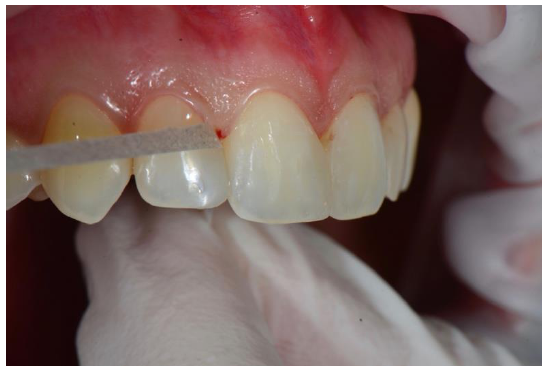
Figure 10. Finishing the margins.